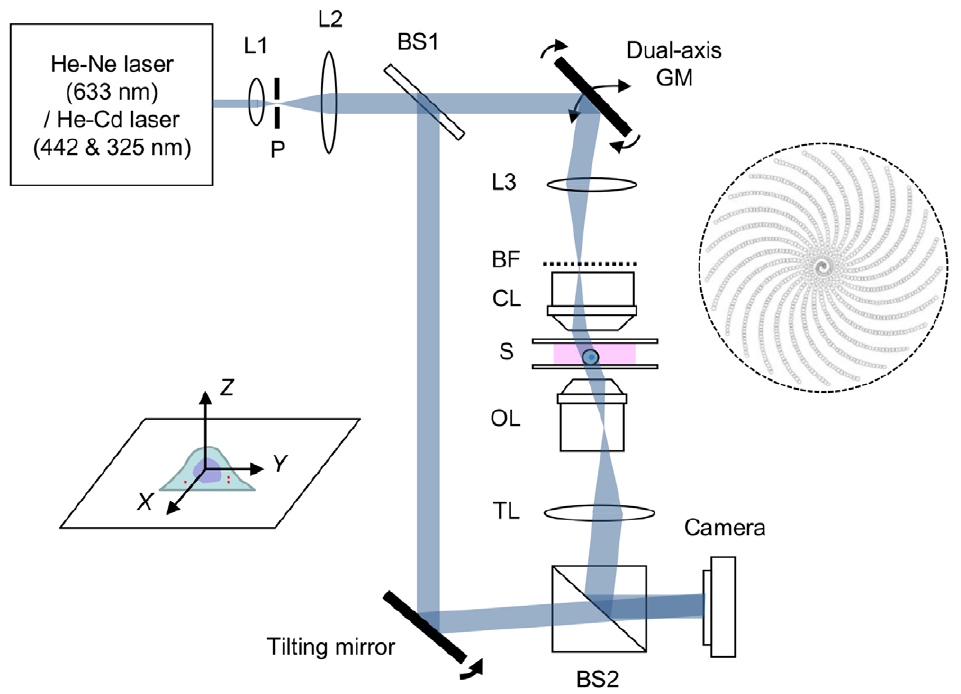
Figure 1. Schematic layout of the regularized tomographic phase microscope (RTPM) set-up. L: lens; P: pinhole; BF: back focal plane; CL: condenser lens; S: sample; OL: objective lens; TL: tube lens; GM: galvanometer mirror; BS: beam splitter. The open circles on the right represent a trace of the focused beam in the back focal plane of condenser lens when the angle of the incident beam is varied at the sample plane.